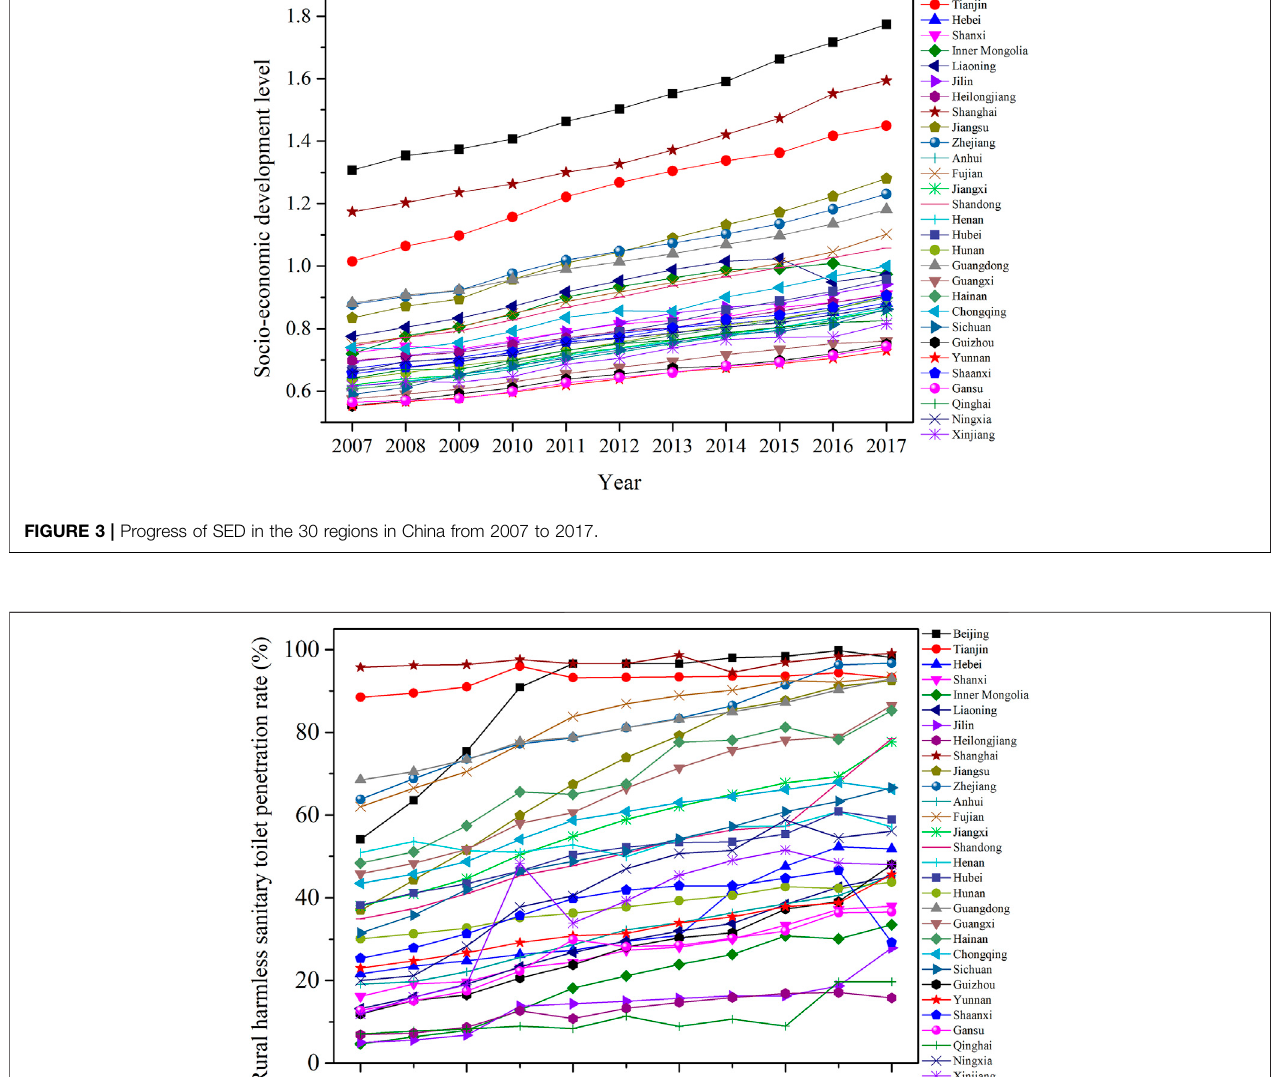
Frontiers in Environmental Science |